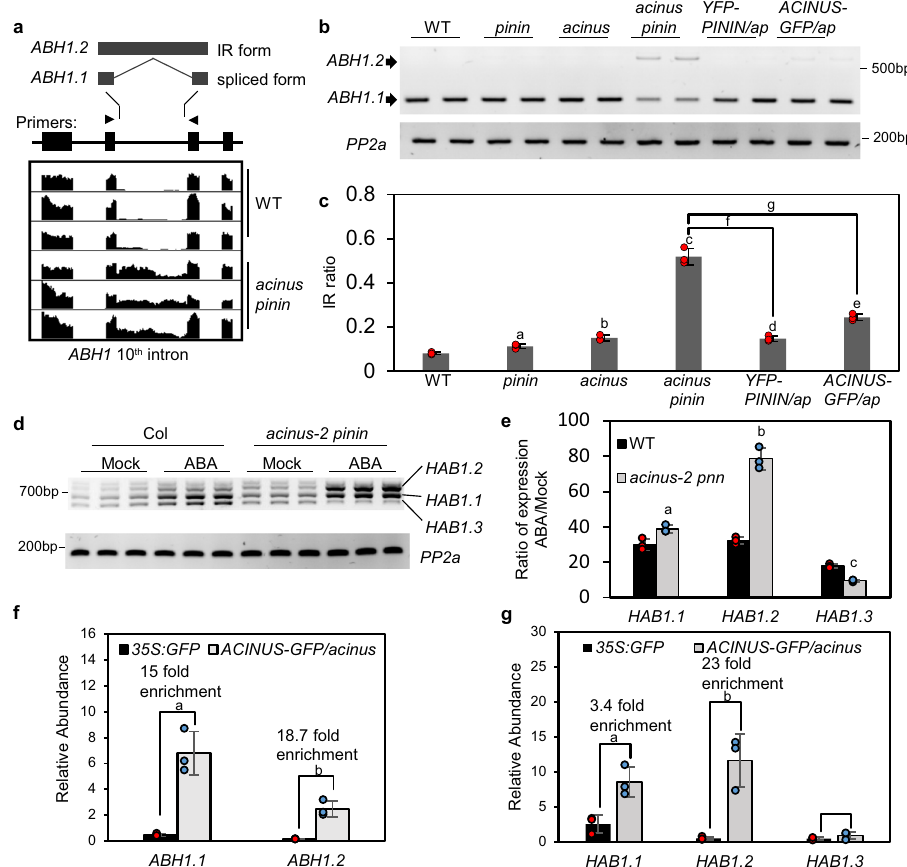
Fig. 4 ABH1 and HAB1 showed increased intron retention in acinus-2 pinin-1 and ABH1 and HAB1 mRNAs are associated with AtACINUS. a Integrative genomic viewer (IGV) display of increased intron retention (IR) of the ABH1 10th intron in acinus-2 pinin-1 compared to WT. b RT-PCR of ABH1 in 12-day-old seedlings of the indicated genotypes using primers at positions indicated by arrowheads in a . c Intron retention ratio of ABH1 10th intron as determined by RT-qPCR in 12-day-old seedlings of the indicated genotypes. The intron-containing form ABH1.2 was highly accumulated while the spliced form ABH1.1 was reduced in acinus-2 pinin-1 compared to WT, the single mutants, or the double mutant complemented by YFP-AtPININ or AtACINUS-GFP . Statistically signi fi cant differences to WT or between indicated genotypes were determined by two-tailed t test. The P values for a, b, c, d, e, f, and g are 1.97E − 2, 5.02E − 3, 1.94E − 3, 4.90E − 4, 9.01E − 4, 1.39E − 3, and 2.32E − 3. d RT-PCR of HAB1 in 12-day-old WT and acinus-2 pinin-1 seedlings treated with ABA (100 μ mol/L for 3 h). e RT-qPCR quanti fi cation of the fold changes of expression levels of each splice forms of HAB1 after ABA treatment of 12-day-old WT and acinus-2 pinin-1 seedlings. The P values for a, b, and c are 2.29E − 2, 3.08E − 3, and 1.60E − 3. f , g Quanti fi cation of ABH1 and HAB1 mRNAs by qPCR after RNA-IP using α -GFP antibody in 7-day-old AtACINUS-GFP/acinus-2 seedlings, compared to 35S::GFP as a negative control. Statistical signi fi cance was determined by two-tailed t test. The P values for a and b in f are 2.24E − 2 and 2.31E − 2. The P values for a and b in g are 2.18E − 2 and 3.54E − 2. Values represent mean ± SD calculated from three biological replicates ( n = 3) for c , e ,